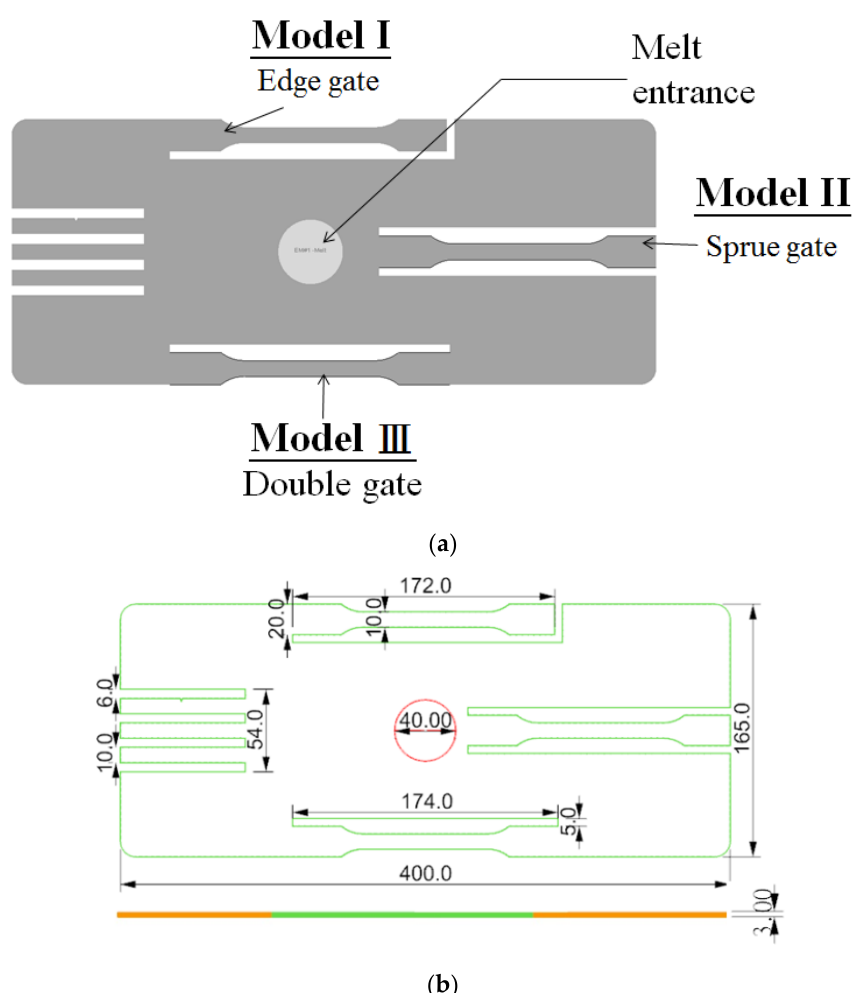
Figure 2. ( a ) The geometrical structure with three ASTM D638 specimens of different gate designs; ( b ) the dimension of the full sample.